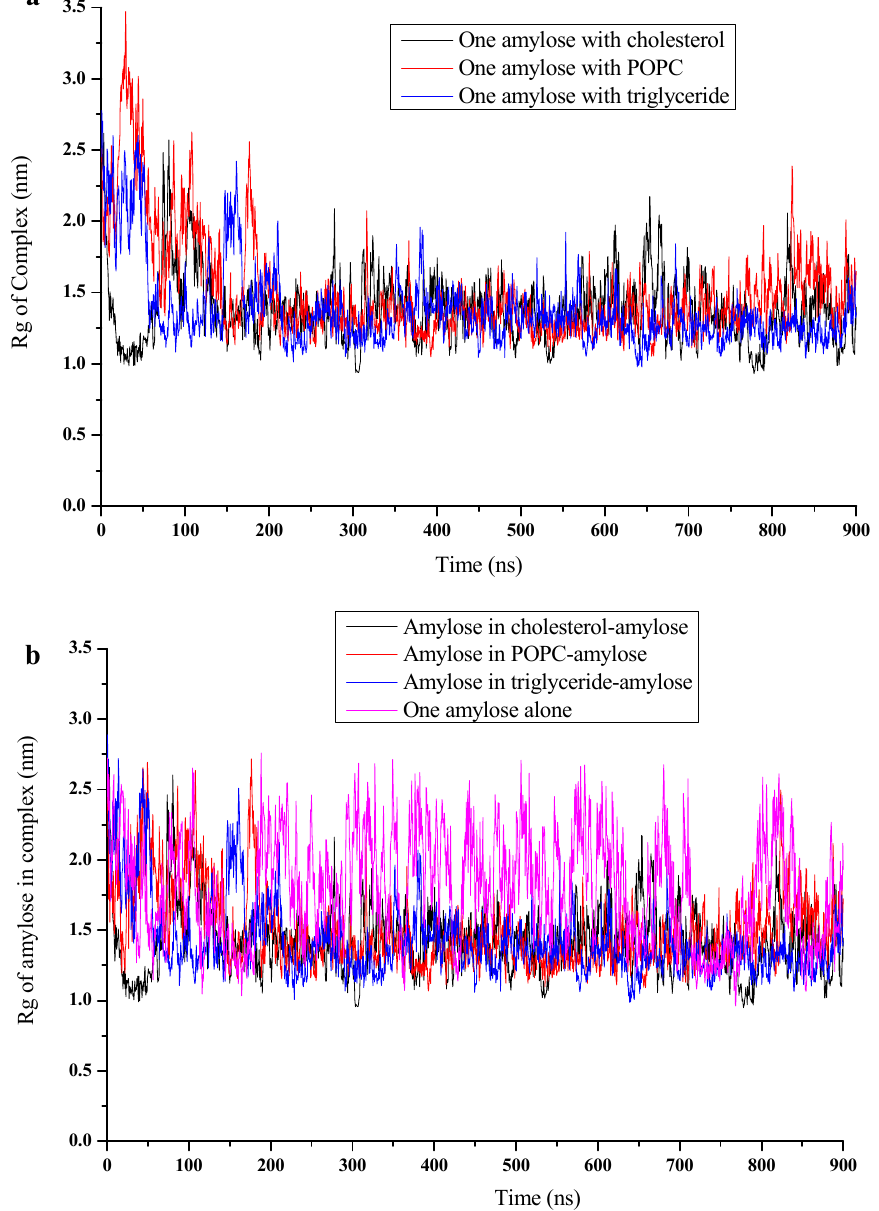
Figure 4. Radius of gyration (Rg, nm) versus time (0 to 900 ns) for ( a ) complex of amylose-cholesterol (black), amylose-POPC (red) and amylose-triglyceride (blue); ( b ) for amylose in amylose-cholesterol complex (black), amylose- POPC complex (red), amylose-triglyceride complex (blue) and amylose alone (pink).